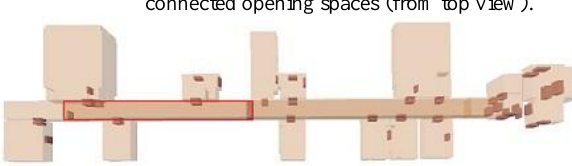
Figure 3.The 3D building model after subspacing based on connected opening spaces (from top view).